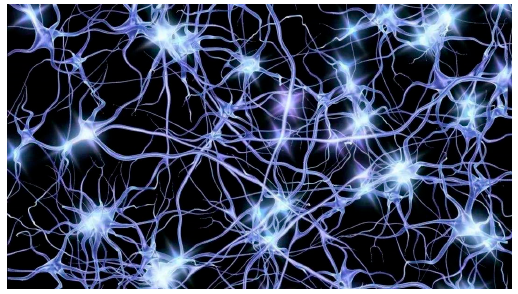
Figure 7. Human neuron.